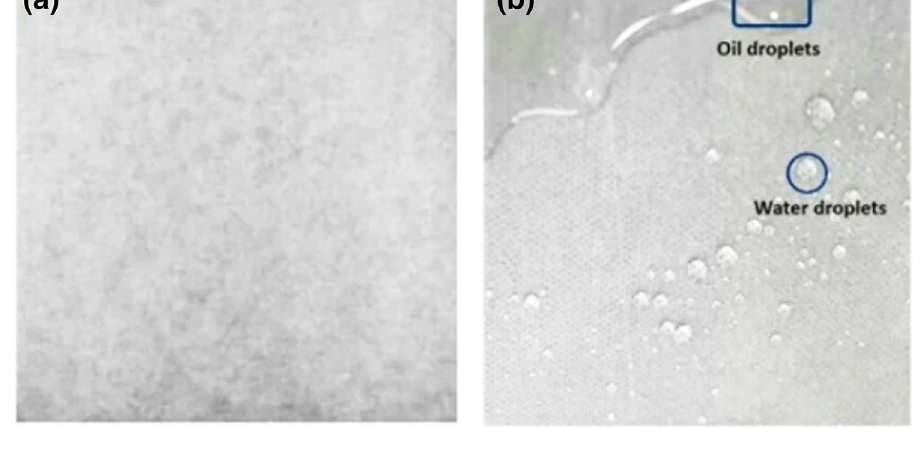
Fig. 16 Color droplet test for oil and water repellency a con- trol nonwoven cotton fabric, b HDTMS-treated nonwoven cotton